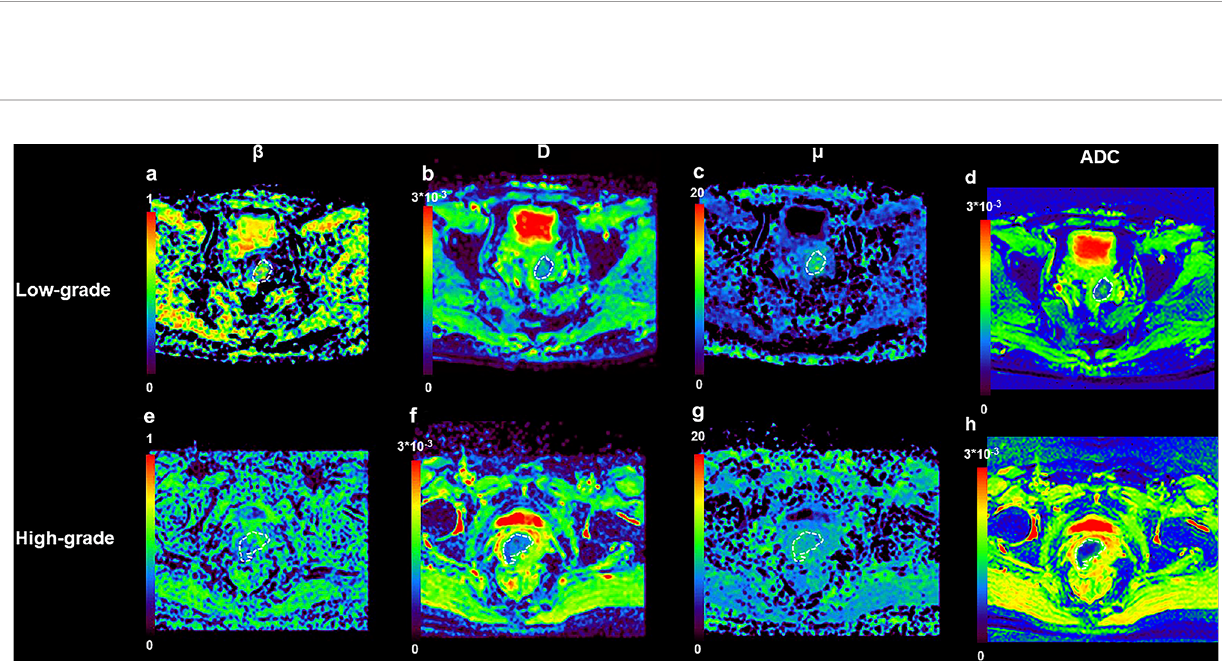
FIGURE 2 | Comparison of the mean ADC (A) , D (B) , m (C) , and b (D) between different tumor subtypes using the Mann – Whitney U test. (E) The ROC curve of using b for classi fi cation of SCC and ACA. ADC, apparent diffusion coef fi cient; ROC, receiver operating characteristic; SCC, cervical squamous cell carcinoma; ACA, cervical adenocarcinoma.